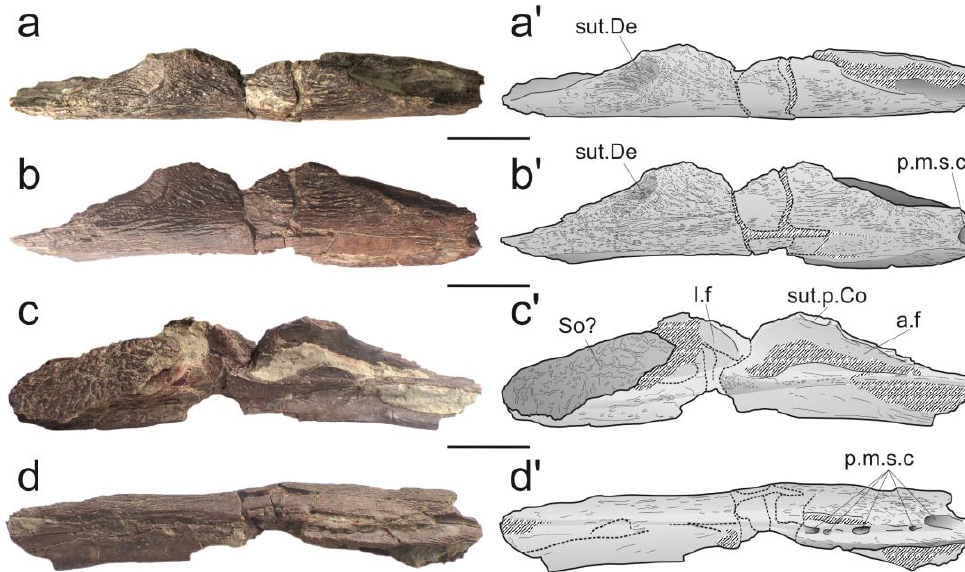
Figure 2. Photographs ( a – d ) and interpretative drawing ( a ′ – d ′ ) of the left angular of an indetermi- nate mawsoniid, Kham Phok locality, basal Cretaceous. Dorsal ( a , a (cid:48) ), lateral ( b , b (cid:48) ), internal ( c , c (cid:48) ), nate mawsoniid, Kham Phok locality, basal Cretaceous. Dorsal ( a , a ′ ), lateral ( b , b ′ ), internal ( c , c ′ ), ventral ( d , d (cid:48) ) ventral ( d , d ′ ) views.